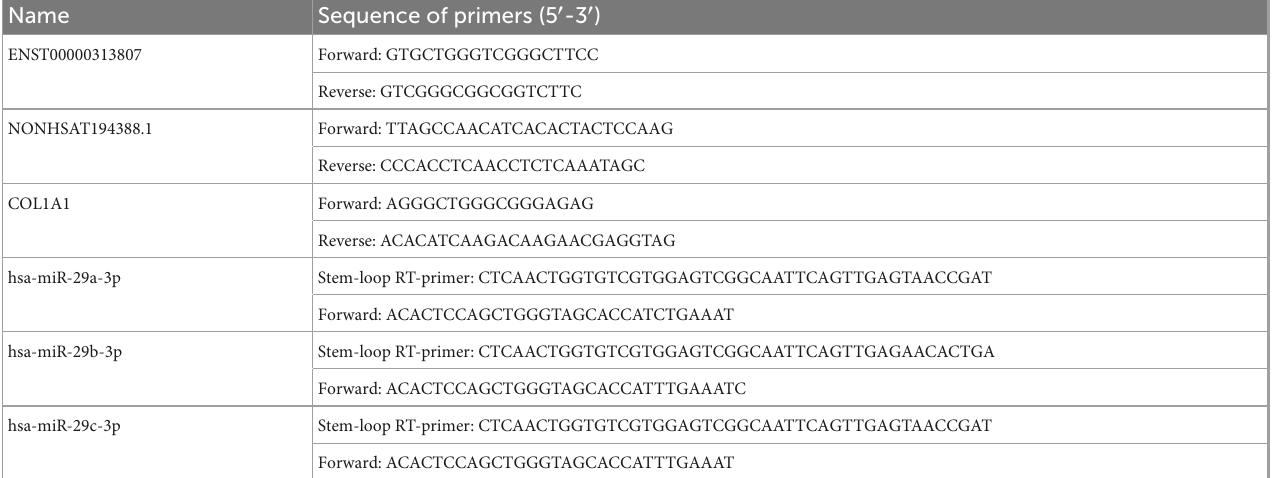
TABLE 1 Sequences of the primers used in this